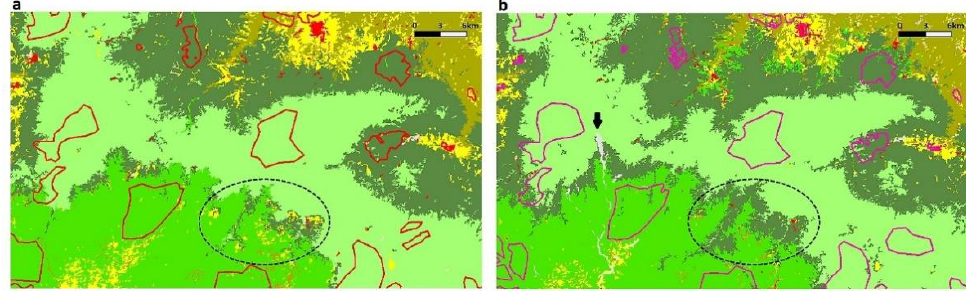
Figure 14. LULC maps generated by the conventional supervised classification method applied to ( a ) the test (2011) and ( b ) base (2016) dates. Ground-truth polygons are included. For these classifications, Kappa indices were obtained of 91.18% for 2011 and 87.64%